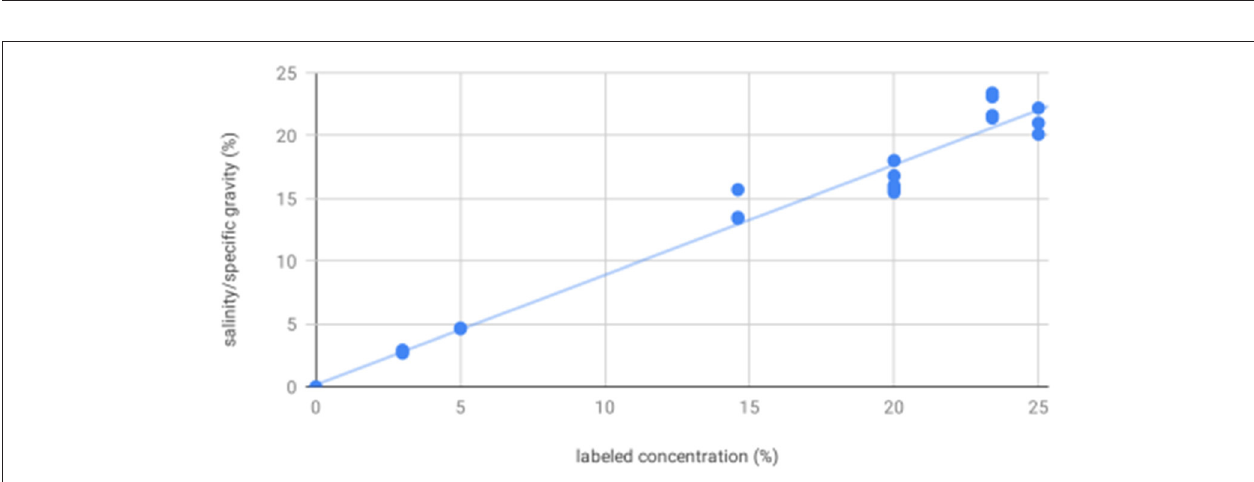
FIGURE 4 | Salinity/specific gravity increases with increasing labeled solution concentration—scatter plot showing salinity/specific gravity as measured by portable refractometer for all solutions increases as a function of increasing labeled solution concentration, as expected. These results showed measured values consistently and proportionally less than labeled concentration by a weighted mean difference of 18% for mannitol and 6% for hypertonic saline. This may be a result of crystallization. As with freezing point depression and vapor point elevation, there was increased variability at higher concentrations. monodisperse (homogeneous mixtures); 12/20 (60%) solutions were monodisperse and 2/20 (10%) solutions were